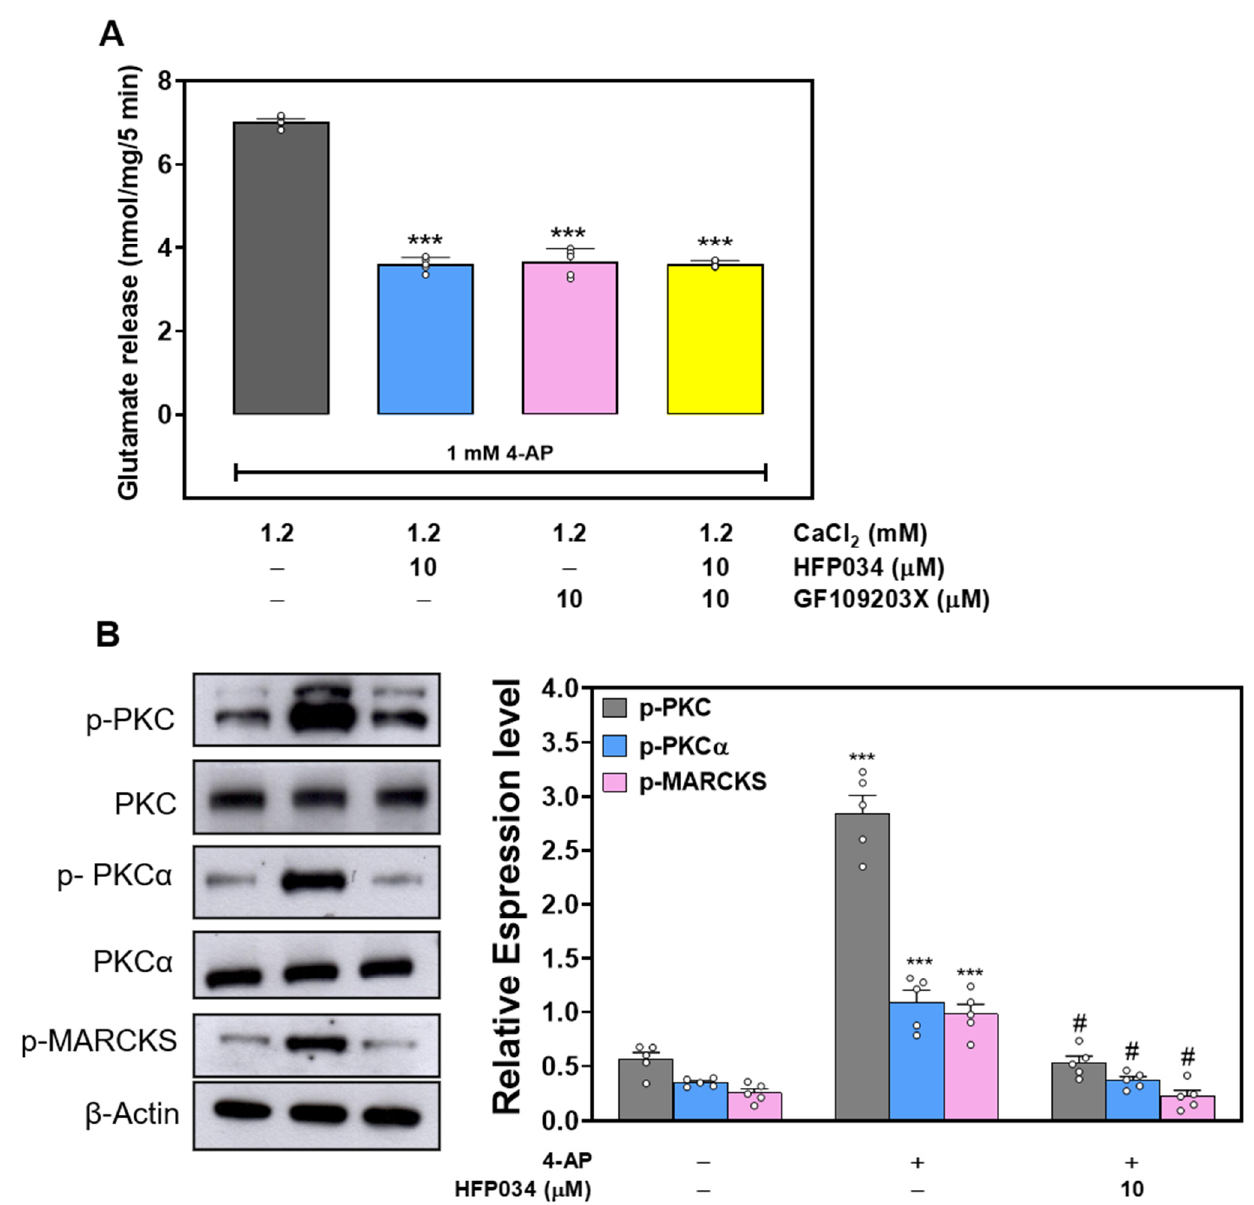
Figure 4. ( A ) Effect of the PKC inhibitor GF109203X on the HFP034-mediated inhibition of 4-AP- evoked glutamate release. ( B ) Effect of HFP034 on PKC and MARCKS phosphorylation evoked by 4-AP. HFP034 or GF109203X was added 10 min before the addition of 4-AP. Each dot represents the value for an individual experiment. Data are presented as mean ± S.E.M. ( n = 5 per group). *** p < 0.001, versus control group. # p < 0.001, versus GF109203X- or 4-AP-treated group. 2.5. HFP034 Attenuates Neuronal Death and Glutamate Elevation in the Hippocampus of Rats